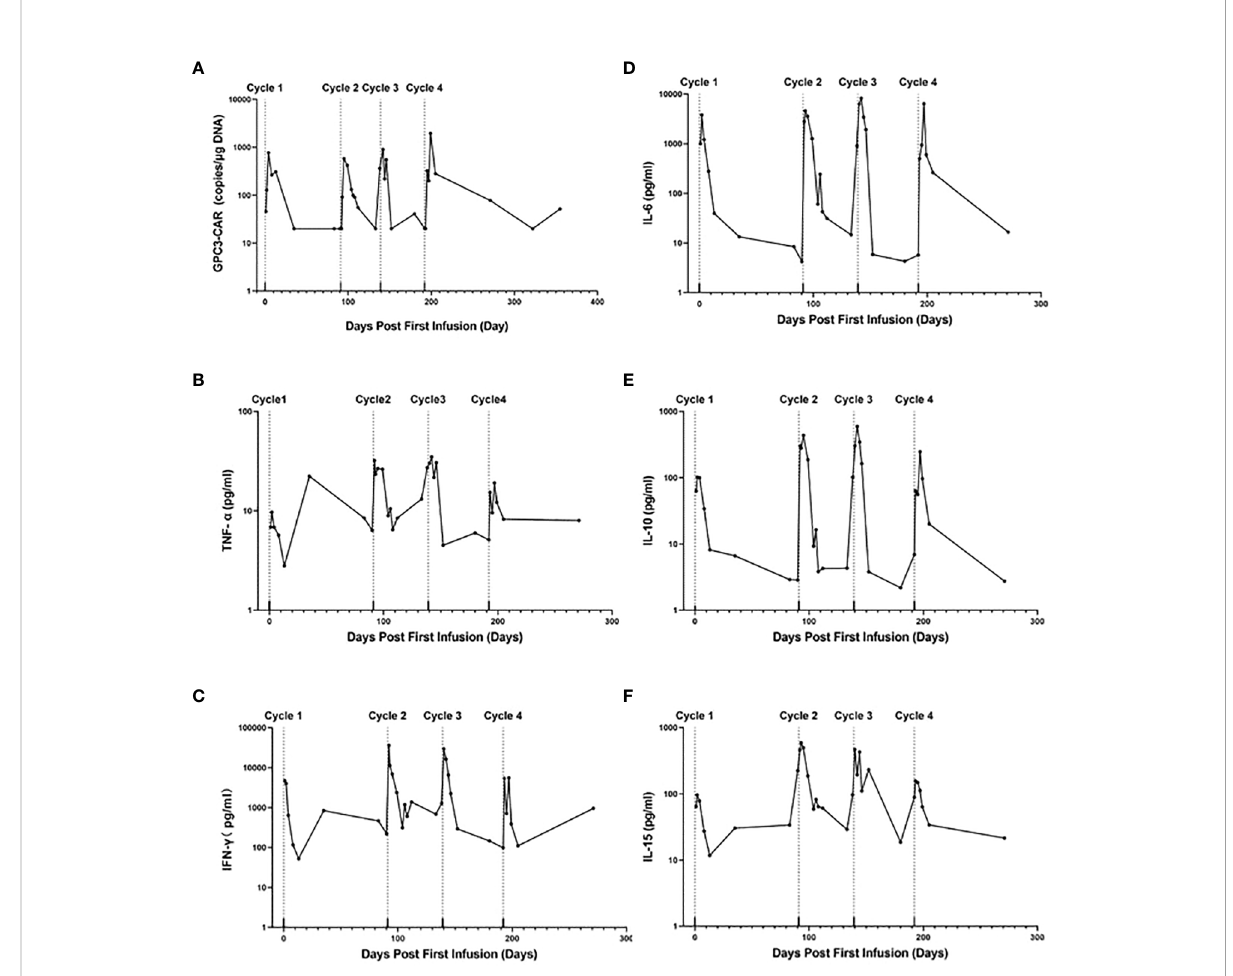
FIGURE 2 CAR-GPC3 expansion and cytokines in peripheral blood. (A) , The copies number of CAR-GPC3; (B) , TNF-a; (C) , IFN- g ; (D) , IL-6; (E) , IL-10; (F) , IL-15. The fi rst cycle CAR T cells started on Day 0; the second cycle of CAR T cells started on Day 91; the third cycle of CAR T cells started on Day 139; The fourth cycle CAR T cells started on Day